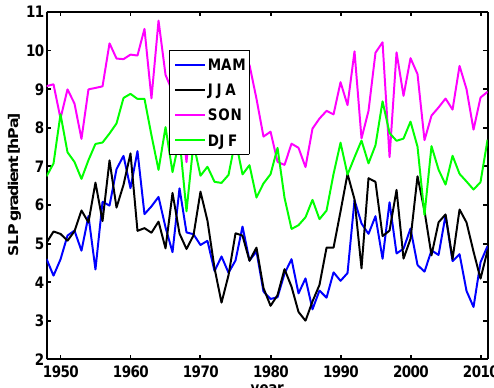
Figure 13. Time evolution of the SLP gradient over the Benguela upwelling system (SLP over ocean (20 ◦ W–10 ◦ E, 15–35 ◦ S) mi- nus SLP over land (12–25 ◦ E, 10–20 ◦ S)), derived from the NCEP/NCAR reanalysis data in the period